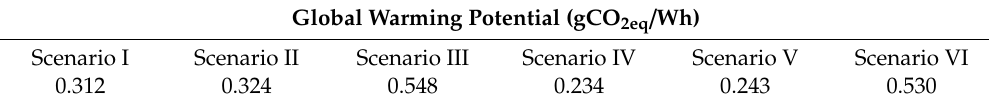
Table 8. GWP results for TE cooling system with heat recovery, gCO 2eq / Wh. Table 7. GWP results for TE cooling system, gCO 2eq /Wh.